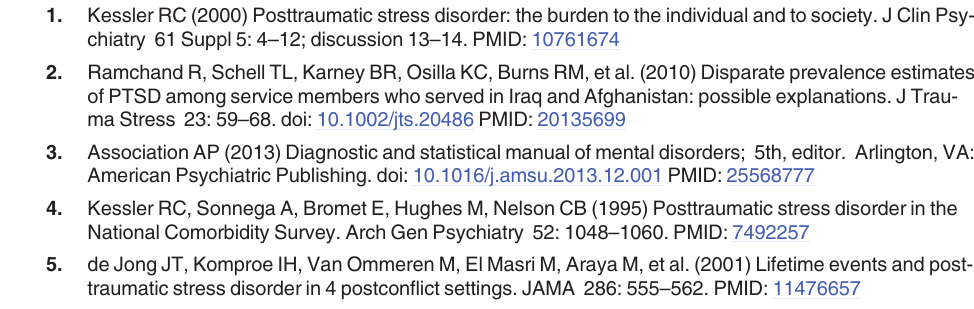
S1 Table. Summary of altered metabolites. (TIFF) S2 Table. Liver gene enrichment suggests inflammation at 24 hrs post-5-day AggE was re- solved at 24 hrs post-10-day